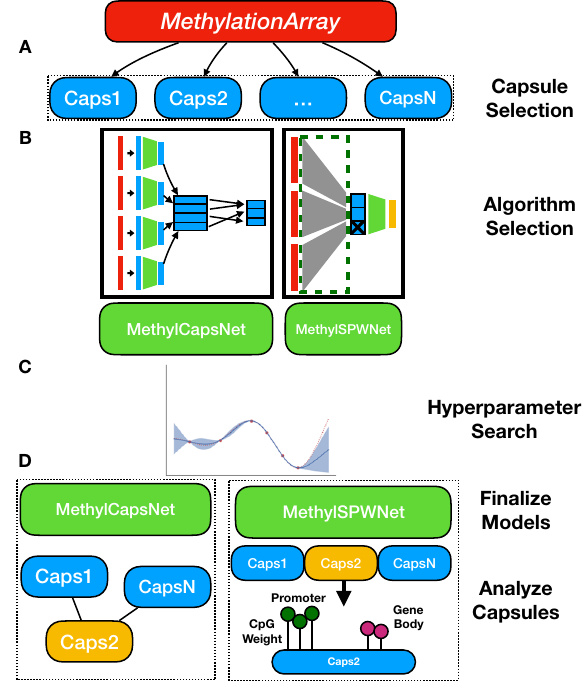
Fig. 6 Description of framework. a User selects capsules to group sets of CpGs from their own supplied list or a prespeci fi ed annotation set. b User selects the modeling approach, MethylCaps- Net , MethylSPWNet , Group LASSO . c Hyperparameter search con- ducted to reveal ideal model speci fi cation. d Final models are fi t, and capsules are interrogated for relationships with one another, relationships to the outcome, and highly weighted CpGs; yellow indicates an important capsule; MethylCapsNet relates the capsule to each other per individual; MethylSPWNet locates important CpGs within a capsule and contextualizes its location; input data into the algorithm are colored